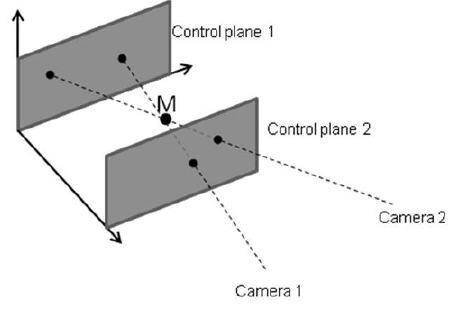
Figure 2. Double plane method with parallel